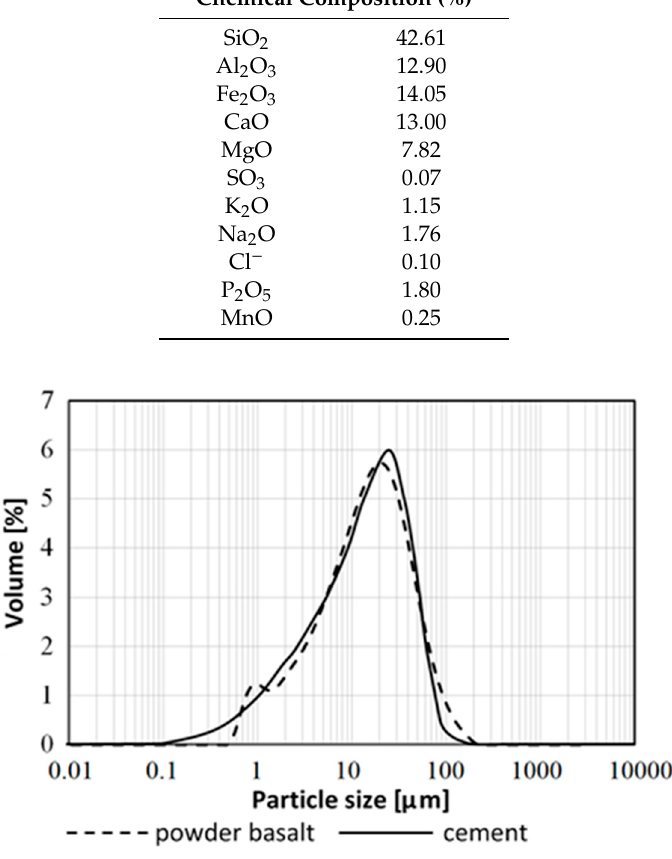
Figure 3. Particle size distribution of basalt powder and Portland cement.